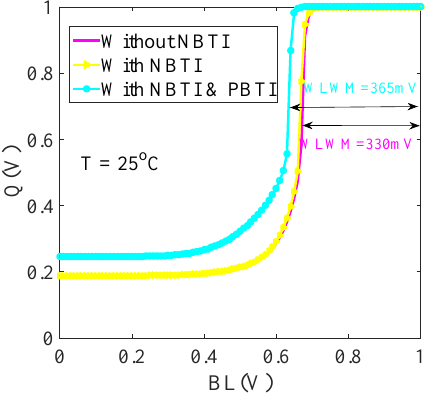
Figure 19. Degradation in WLWM under 10 year NBTI and PBTI stress. Table 3. Degradation in SRAM stability and performance with 10 Year